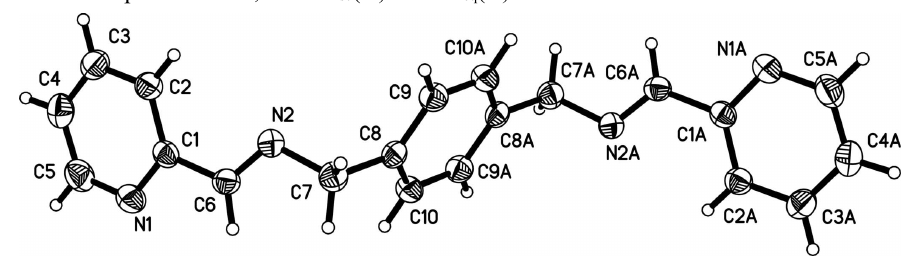
The molecular structure of the title molecule, with the atom-numbering scheme. Displacement ellipsoids are drawn at the 30% probability level [symmetry code: (A) 1 - x, 1 - y, 1 -